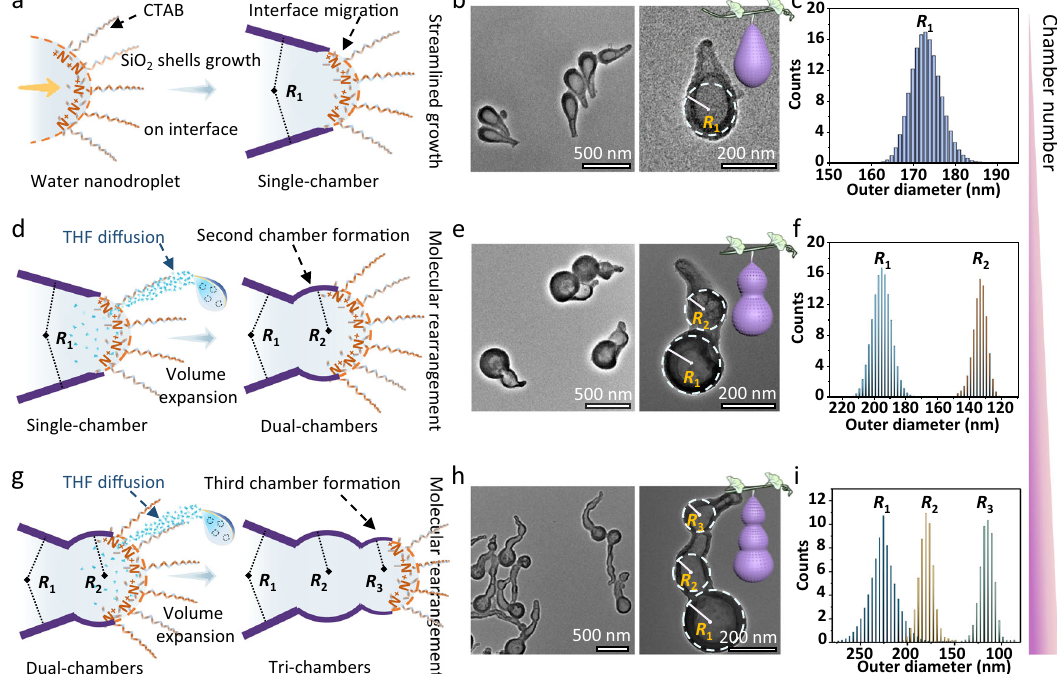
Fig. 2 | Hierarchical multi-chambered mesoporous silica nanoparticles with tunable chamber numbers. a , d , g The illustration of the nanodroplet remodeling process. By controlling the number of the THF additions, the chamber numbers can be tuned from one to three. b , e , h TEM images and c , f , i thedistribution histograms